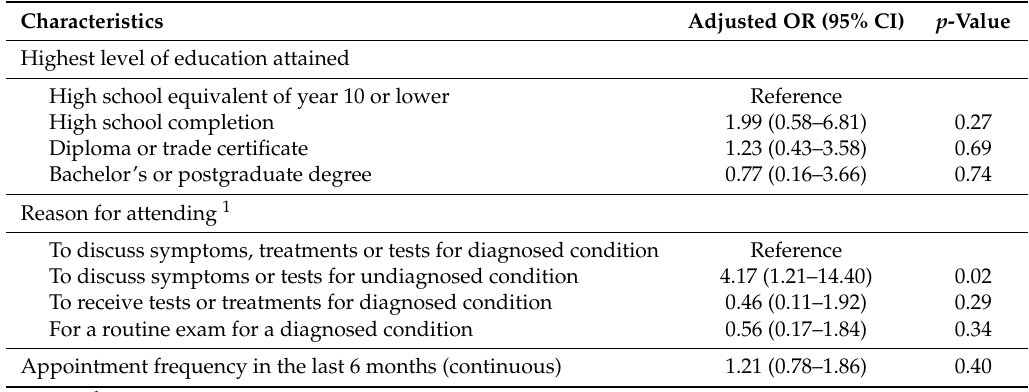
Table 3. Adjusted odds of selecting “Provide more information on treatment and condition during a clinical appointment”.